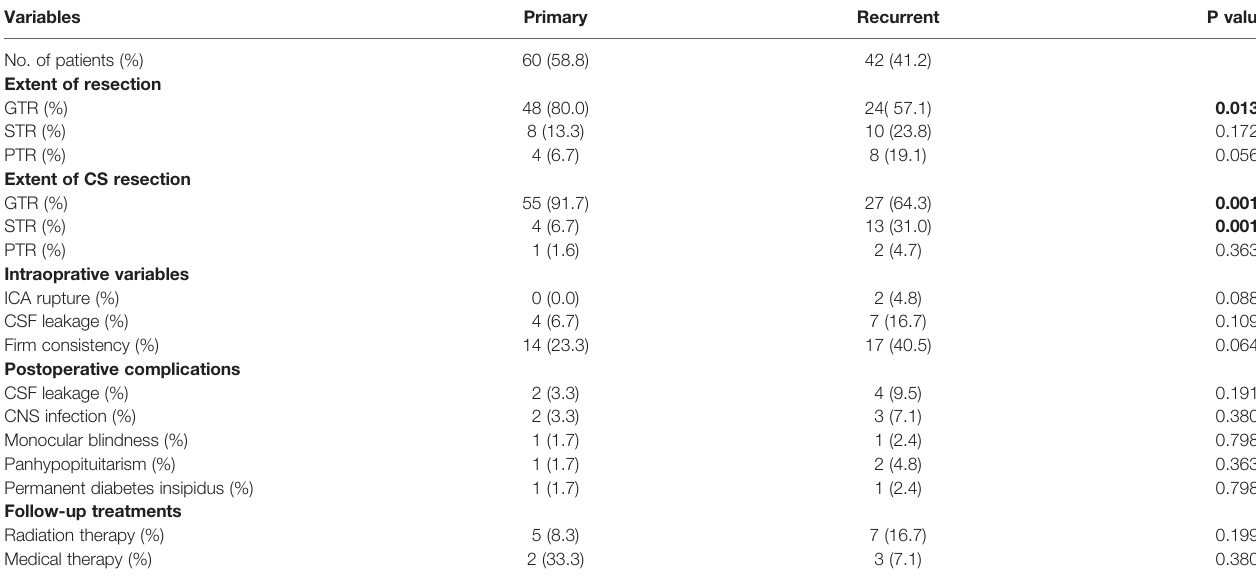
TABLE 3 | Surgical results and postoperative complications strati fi ed by primary and recurrent pituitary adenomas.